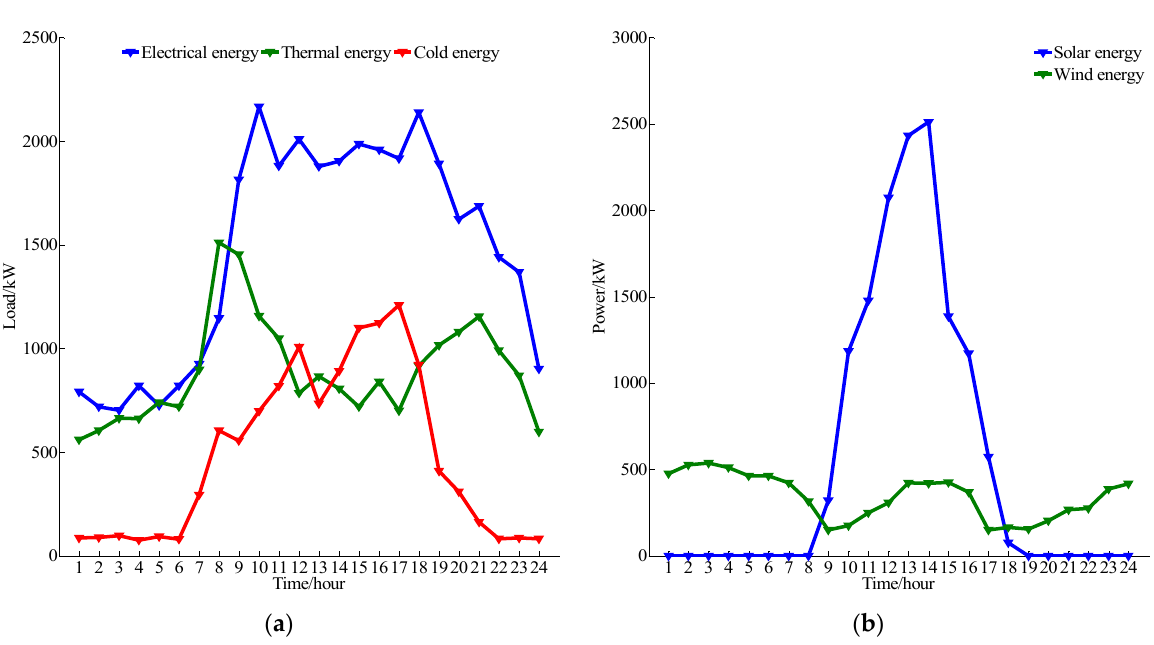
Figure 4. Loads and electricity of renewable energy of the whole MESs: ( a ) total electrical load, heat load, and cold load; ( b ) total PV and wind energy power output in each MES.